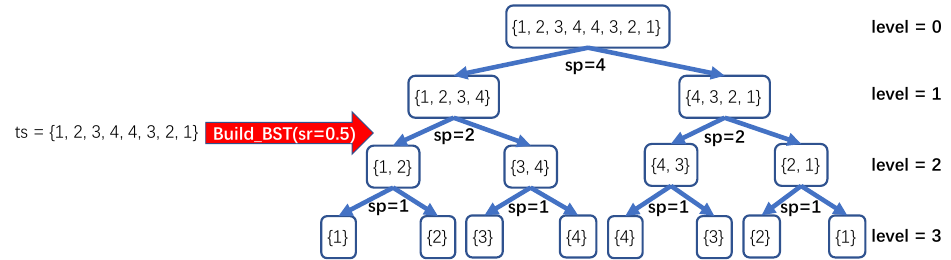
Figure 2. An example for Binary Subsequence Tree (BST) construction